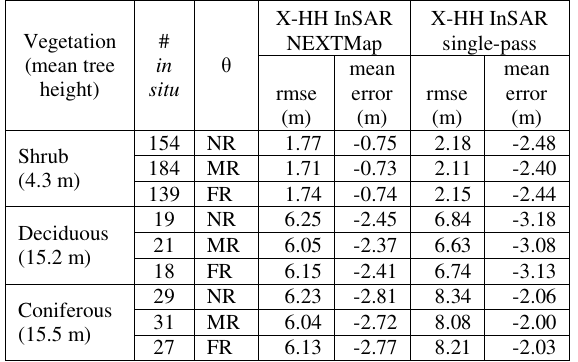
Table 3. NEXTMap and single-data take X-HH InSAR-derived h spc error assessment against in situ vegetation canopy height for the Arizona site, stratified by vegetation cover type and incidence angle range for <10 º terrain